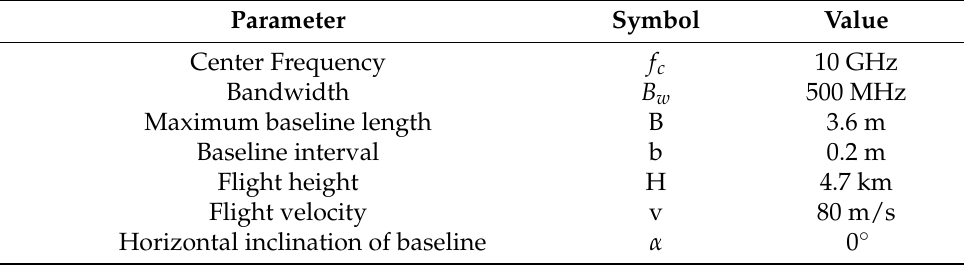
Figure 6. Airborne array TomoSAR system. Table 1. Airborne array TomoSAR